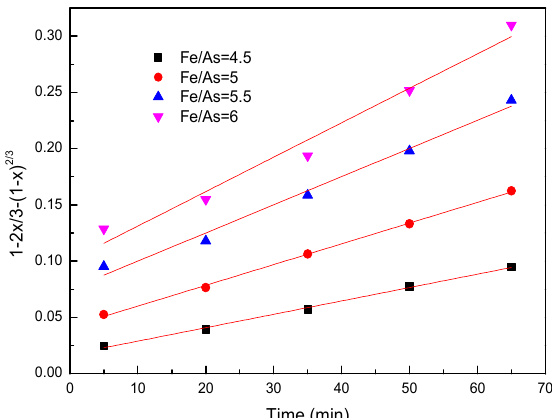
Table 3. Correlation coefficient (R 2 ) values for the different the molar ratios of iron to arsenic and kinetic data.